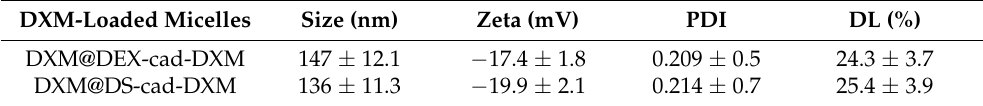
Table 1. The characterization of DXM-loaded micelles. DXM-Loaded